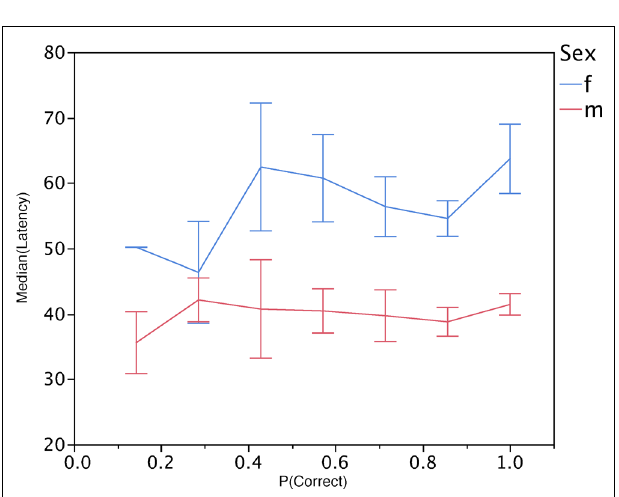
video games. Experience was analyzed as a continuous variable (0–24) but has been dichotomized here into low (0–11) and high (12–24) for presentation purposes. All lines are those derived from the best fitting statistical model.